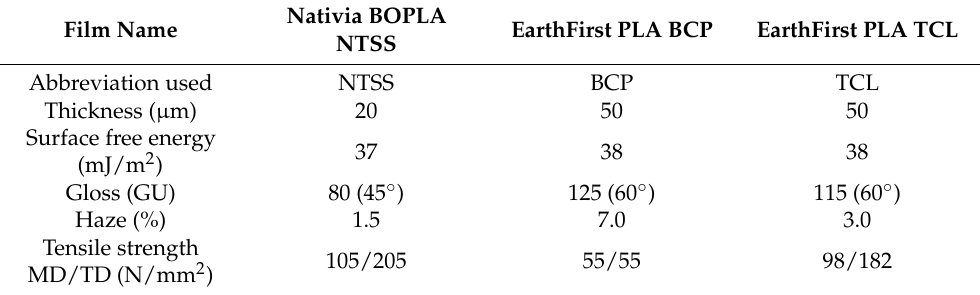
Table 1. The characteristics of the films used for the research (data provided by film